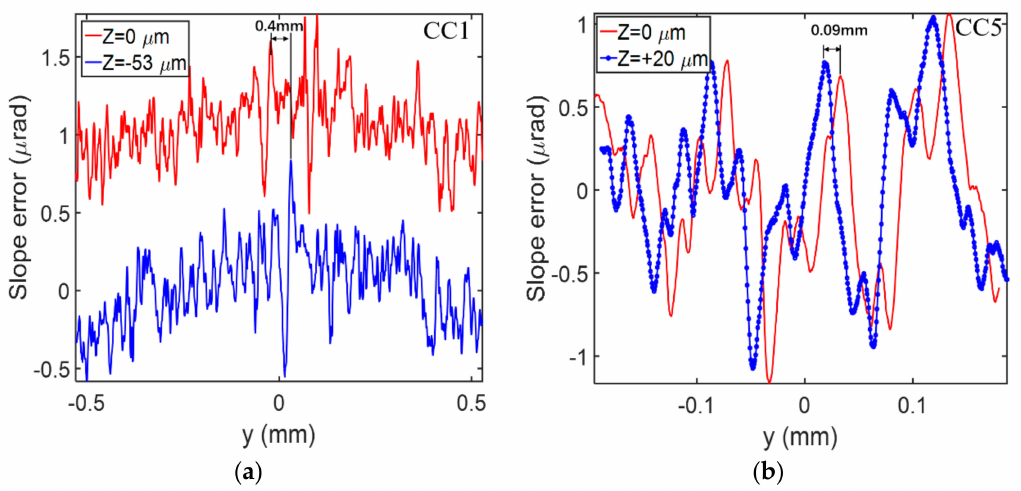
Figure 4. ( a ) The slope errors of di ff erent CC1 vertical positions. For comparison, the red curve is shifted up by 1 µ rad. ( b ) The slope errors of di ff erent CC5 vertical